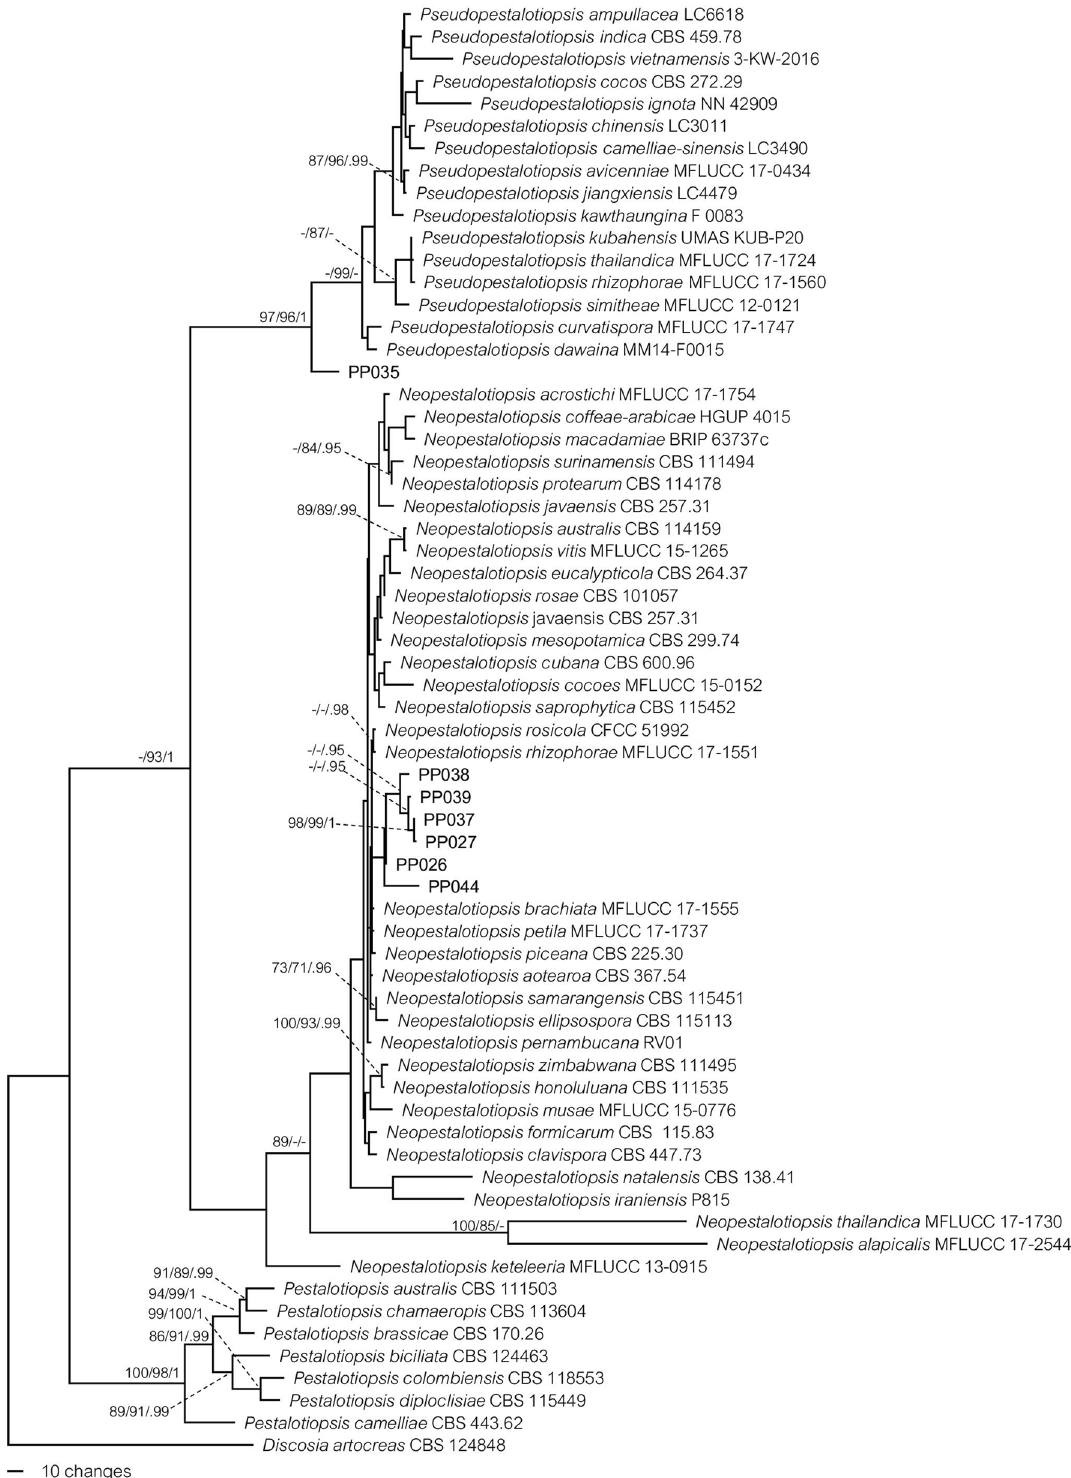
Figure 4. MP tree based on analysis of combined ITS, β-tubulin, and tef1 dataset. Discosia artocreas (CBS124848) was used as the outgroup taxon, and new isolates are in bold. Bootstrap support values for Maximum Parsimony (MP-BS) and Maximum Likelihood (ML-BS) smaller than 70% (left and middle) are not shown and Bayesian posterior probabilities (BPP) equal to, or higher than 0.95 PP (right) are indicated at the nodes